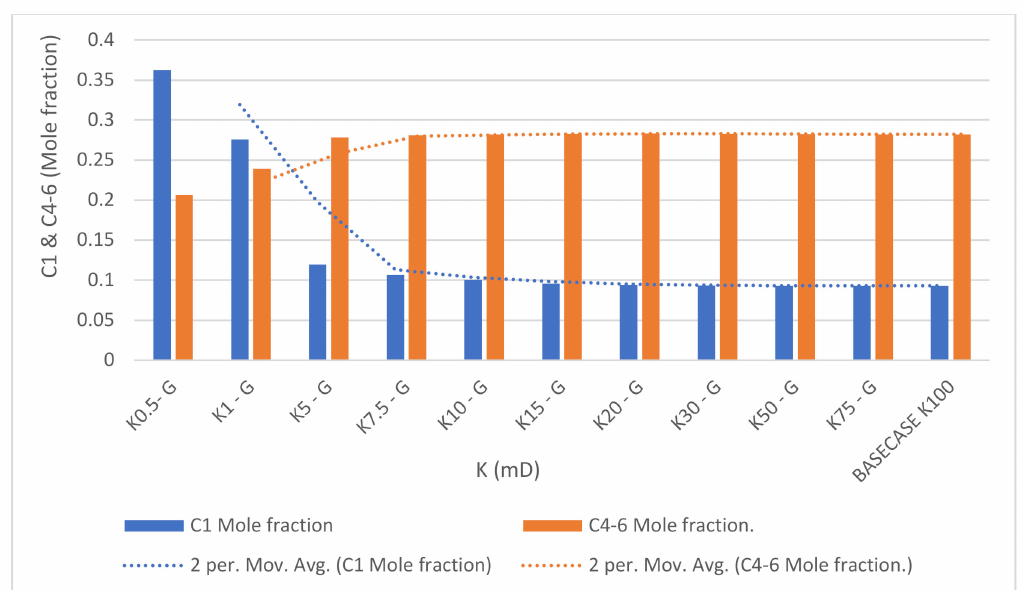
Figure 13. Comparison of the cumulative hydrocarbon composition (C 1 and C 4–6 ) at the wellbore, global case.